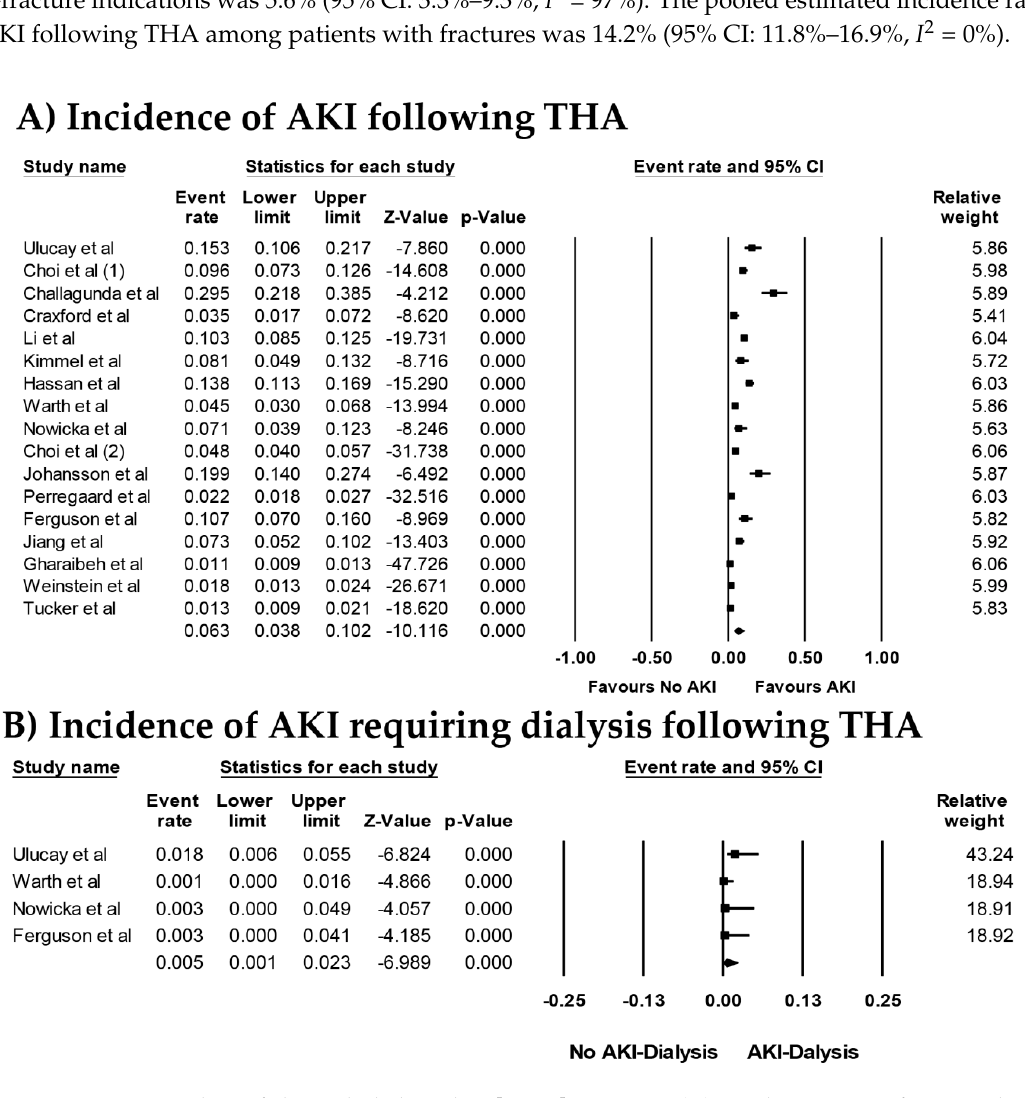
Figure 2. Forest plots of the included studies [18–33] assessing ( A ) incidence rates of AKI and ( B ) incidence rates of AKI requiring dialysis following THA. A diamond data marker represents the overall rate from each included study (square data marker) and 95% confidence interval (CI).